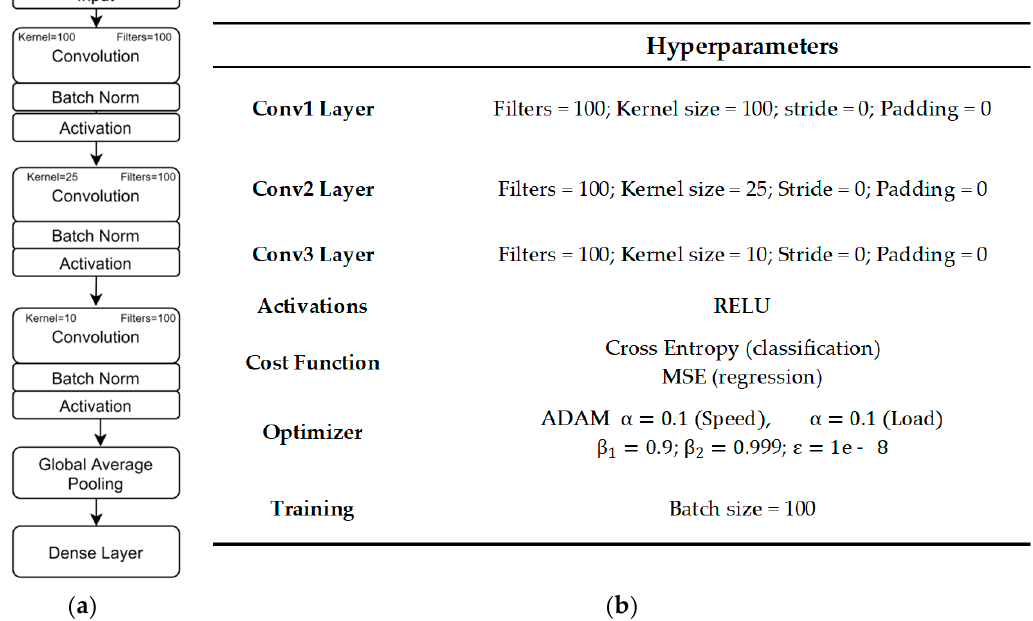
Figure 8. Proposed architecture diagram ( a ) and hyperparameters ( b ).